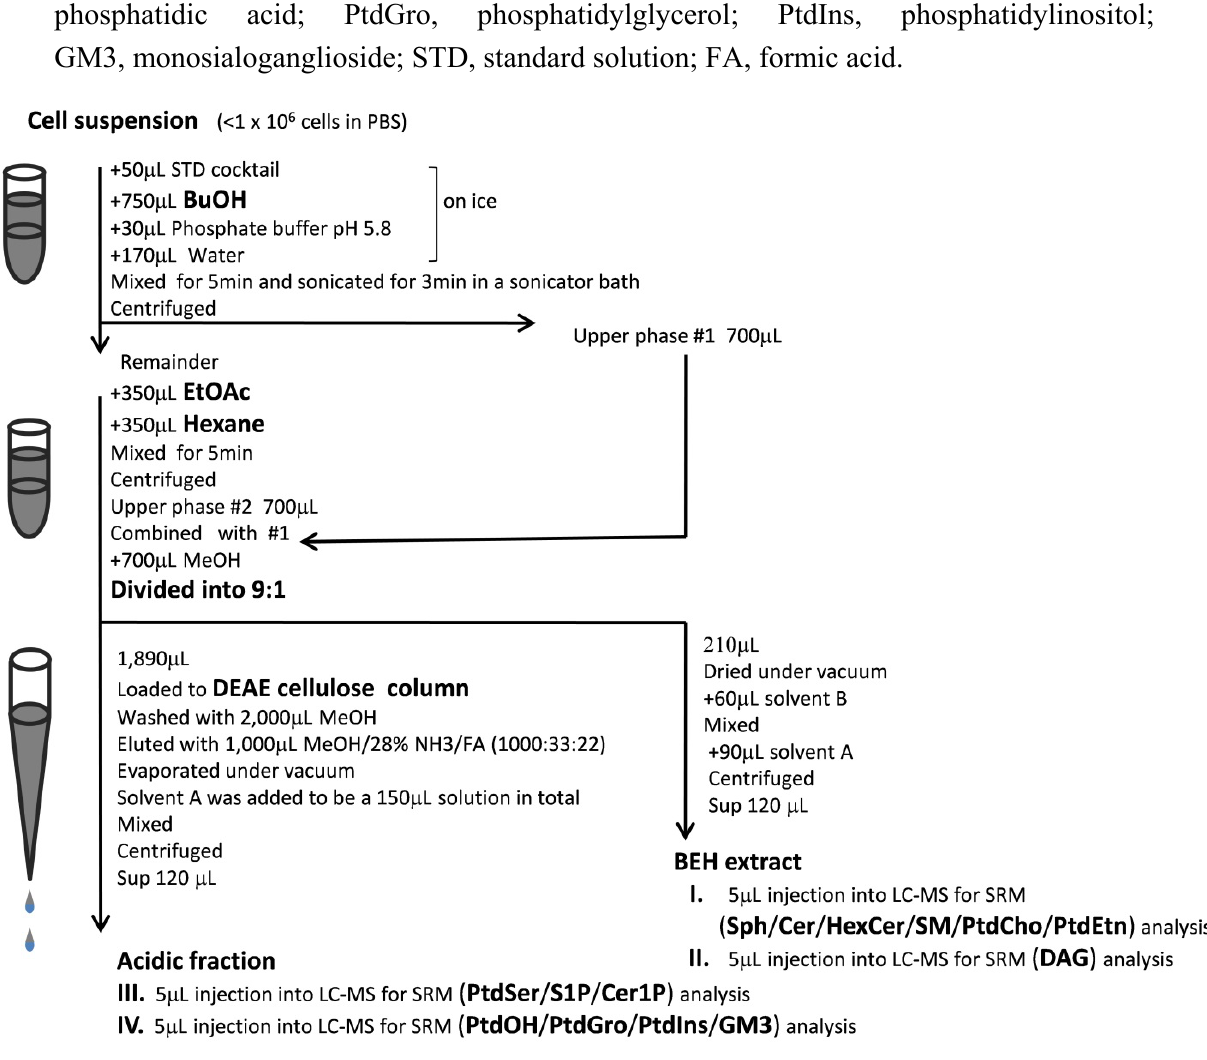
Figure 1. Flow chart illustrating sphingolipid, glycerophospholipid (GPL) and diacylglycerol (DAG) sample preparation and analysis. Butanol and ethyl acetate/hexane (1:1) were used for the first and second extractions, respectively. To reduce the ion suppression effects associated with large amounts of phosphatidylcholine (PtdCho) and phosphatidylethanolamine (PtdEtn) in the sample, a DEAE fractionation step was